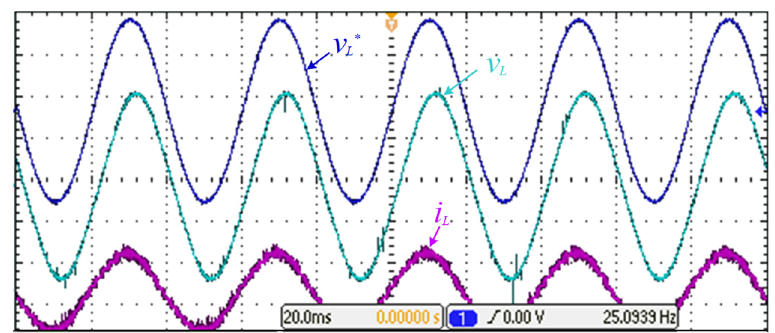
Figure 16. Measurement of the 7-level inverter terminal-voltage at stand-alone load-voltage control.